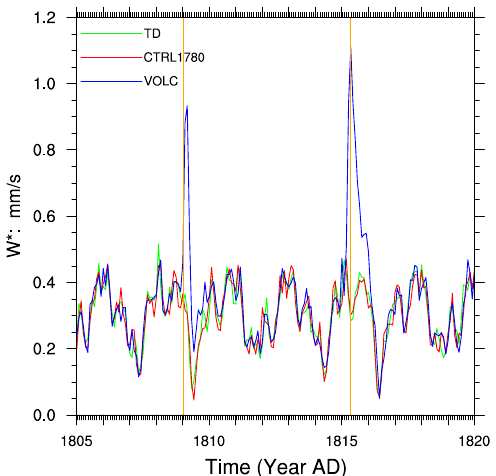
Fig. 10. Residual vertical velocity (calculation as in Andrews et al. (1987), Eqs. 3.5.1 to 3.5.3) from 1805 to 1820 for the DM- CTRL1780, DM-VOLC and DM-TD simulations at 30hPa height averaged from 20 ◦ N/20 ◦ S. The two major volcanic eruptions in 1809 (unknown) and 1815 (Tambora) are marked with two vertical orange lines. The data are averages of the three ensemble members and are not